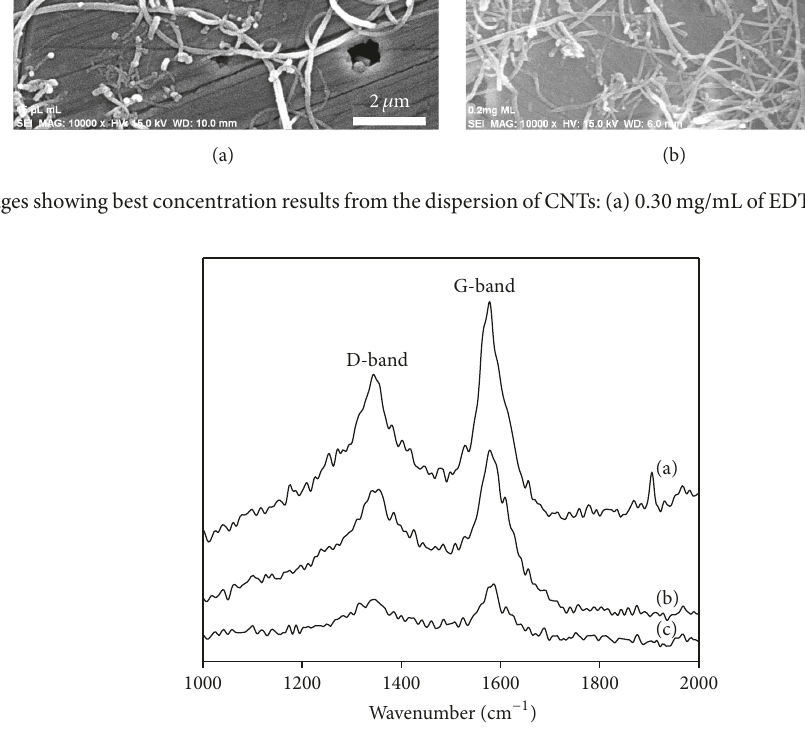
Figure 6: Raman spectra of the CNTs: (a) as-synthesized, (b) dispersed with EDTA, and (c) dispersed with